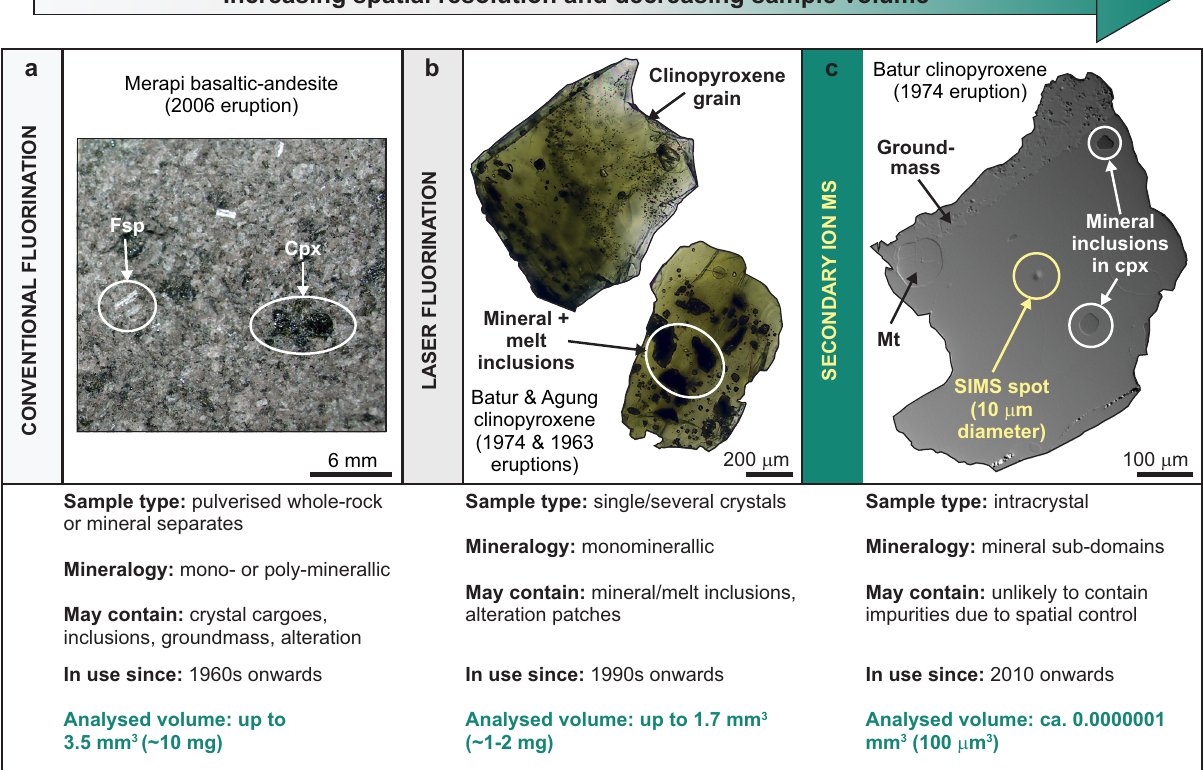
Fig. 2 Evolving approaches to oxygen isotope analysis. a Photograph of a lava sample from Merapi with visible feldspar and clinopyroxene phenocrysts. Conventional fl uorination (CF) is typically utilised to analyse oxygen isotope ratios of pulverised bulk lava and/or mineral separates. b Extended focus images (EFI) of polished clinopyroxene crystals in Agung and Batur lavas showing internal features such as mineral and melt inclusions. Laser fl uorination (LF) is typically utilised to analyse oxygen isotopes in single minerals or mineral separates. c Back Scattered Electron (BSE) image of a clinopyroxene mineral grain from Batur in topographic mode showing surface features. Although this grain also contains mineral inclusions exposed at the polished surface, these are easily avoided with SIMS due to the high degree of spatial control. Abbreviations: Cpx, clinopyroxene; Fsp, feldspar; MS, mass spectrometry; Mt,